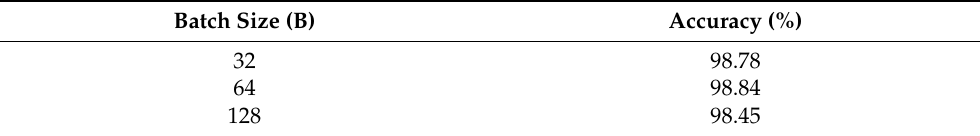
Table 6. Traffic sign recognition accuracy (%) at different batch sizes (L = 0.001, O =